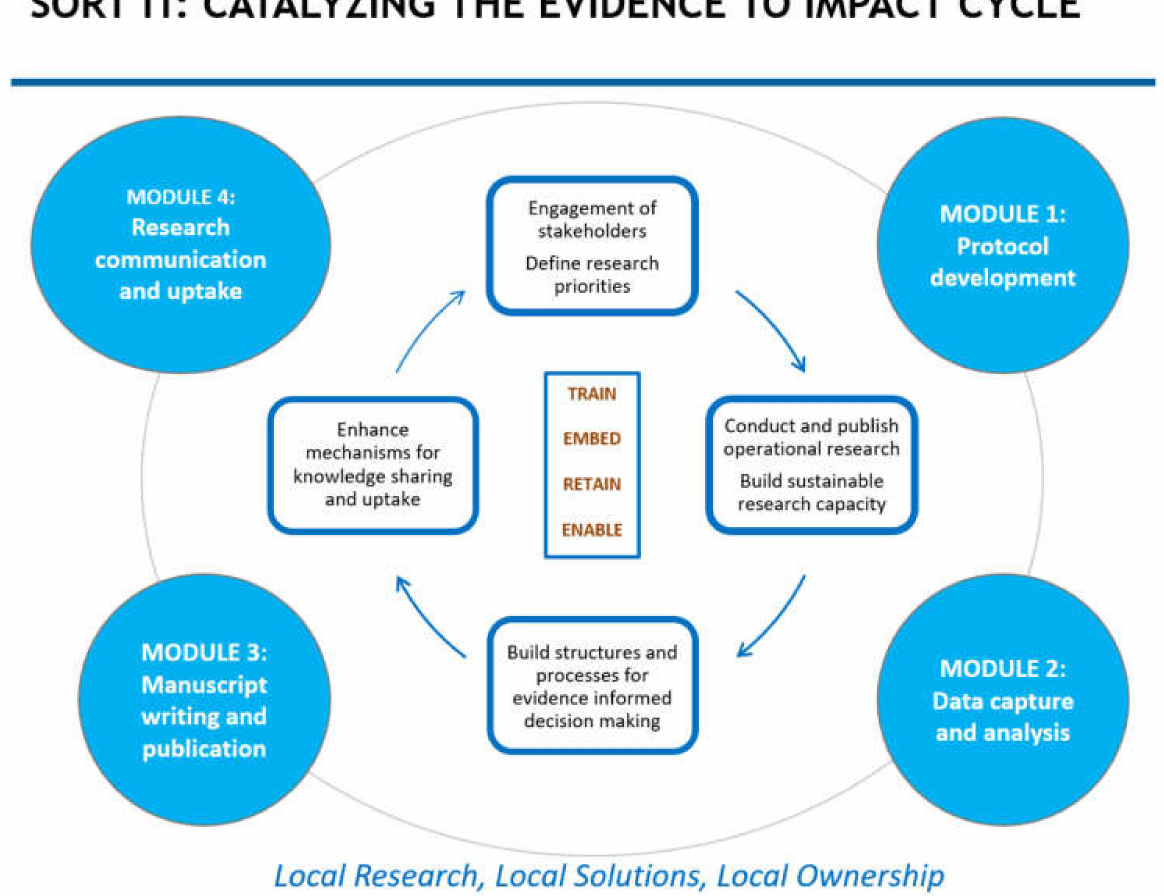
Figure 1. The SORT IT evidence to impact